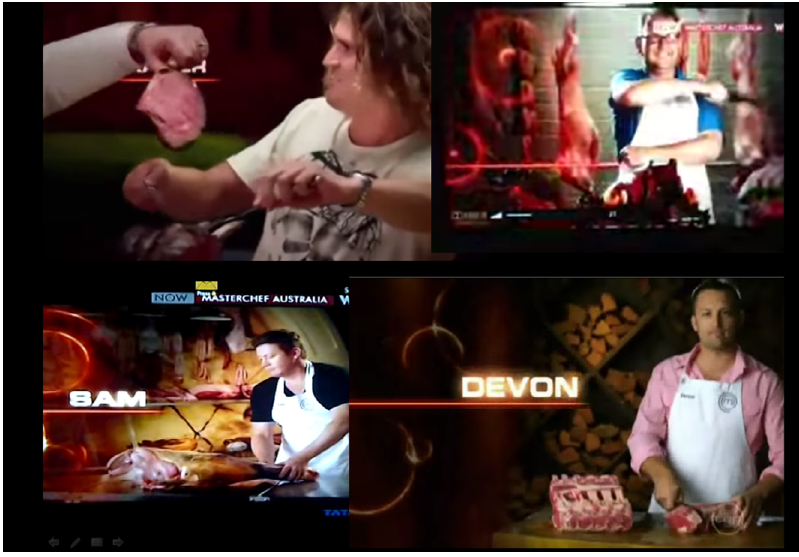
Figure 3. Male contestants handling red meat in introduction